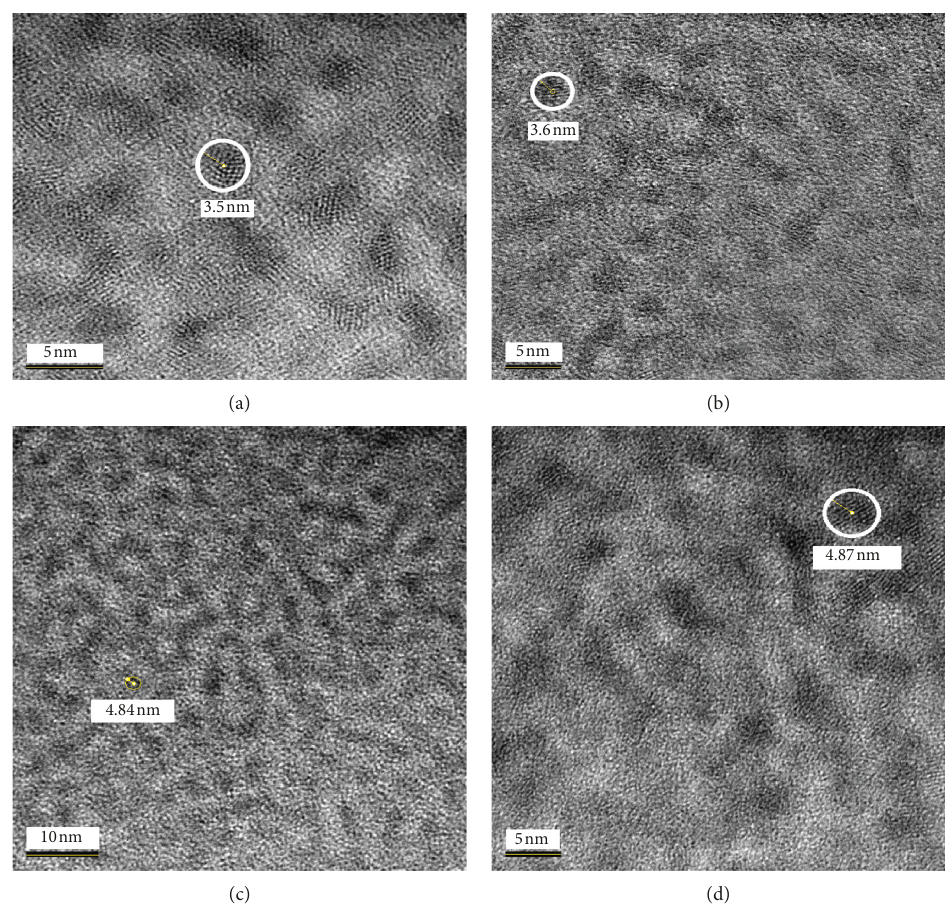
Figure 2: HRTEM images of bare CdSe core QD synthesized at 160 ° C for 1min (a) and 20min (b) reaction times, and of CdSe/ZnS core/ shell QD synthesized at 160 ° C (c) and 170 ° C (d) for 20 min reaction time, respectively.